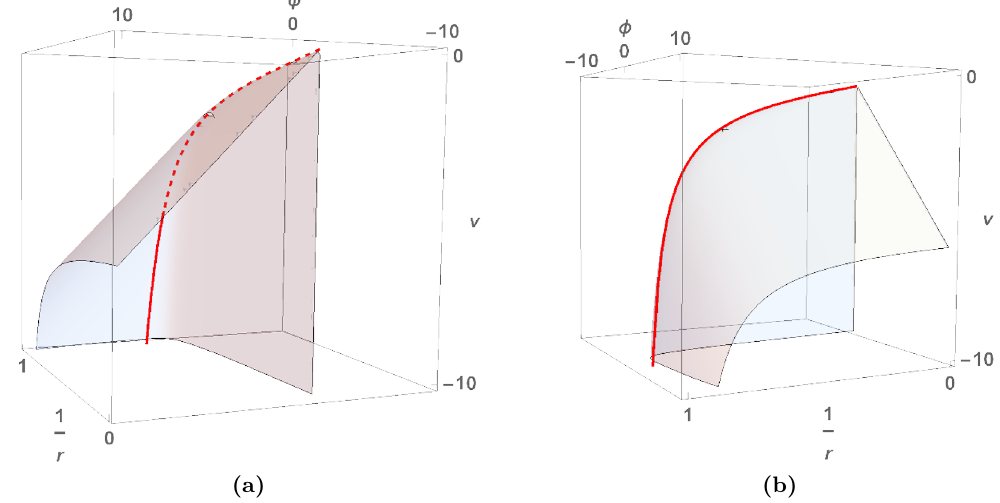
Figure 9. Support of the shock wave (C.13) emitted by a null outgoing geodesic with boundary insertion point v = 0 , φ = − 2 , viewed in retarded coordinates ( v, r, φ ) from two different out out perspectives. The horizon radius has been set to r = 1 and the outgoing geodesic is indicated by + the red line. The shock wave is emitted from the geodesic towards the conformal boundary. The shock wave (C.17) associated with a conformal boundary with cylinder topology used in the main text, is found by adding images in order to implement the periodic identification φ ∼ φ + 2 π